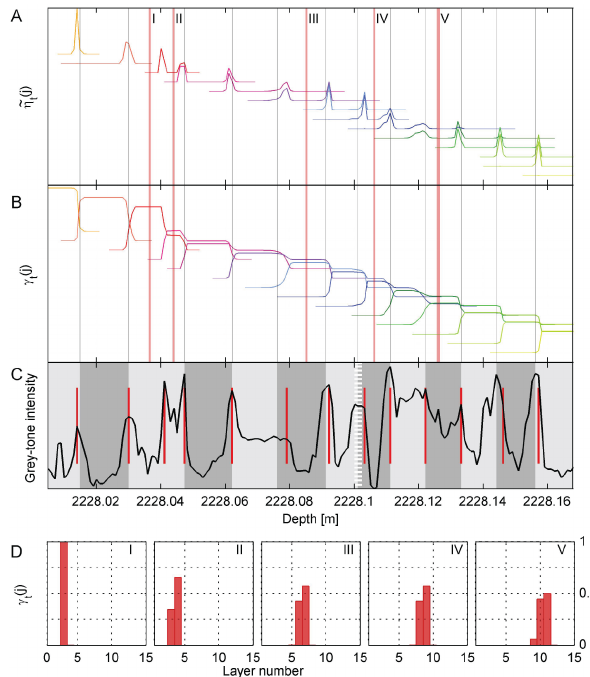
Fig. 3. Layer detection algorithm applied to line-scan data from NGRIP. (A) and (B) : The posterior probabilities ˜ η t (j) ≡ P(S t = ‘ j , o 1 : T ) and γ t (j) ≡ P(S t = ‘ j , o 1 : T ). Probabilities corresponding to individual layers are drawn in different colours. All probabilities are plotted to the same scale, but shifted slightly downwards with increasing layer number to enhance visibility. (C) Line-scan data from NGRIP (black line). The alternating bright and dark grey banding shows the annual layers in the GICC05 chronology, an uncertain layer boundary is marked with white dashes. Superimposed (red lines) are the most likely layer boundaries as inferred from the Forward-Backward algorithm. These are found as those places where the most likely layer number – i.e. mode of the γ t (j) distributions with t fixed, see examples in (D) – changes with depth. (D) Inferred probability distributions of the annual layer number ( γ t (j) ) at the positions I–V, indicated with red bars in (A) and (B)